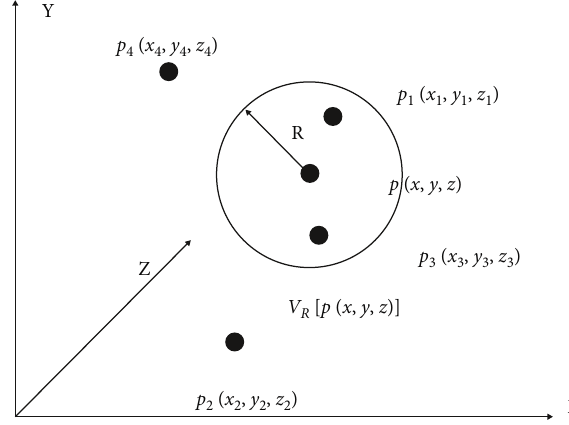
Figure 2: Statistical filtering.